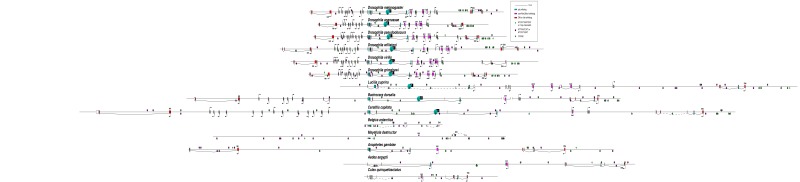
Instances of motifs similar to the EO053 conserved Hox-like motif in the pb region across Arthropods.Best to view high-quality images and zoom in and out as needed. Visualization of the pb region from the 80 species listed in Figure 6—figure supplement 1. Refer to Figure 6—figure supplement 1 for phylogenetic relationships between species. Each diagram is aligned with the pb ortholog (blue-green) underneath each species name, with labial to the left (red, if present), and Hox3 (magenta, if present) and Dfd (red, if present) to the right of each pb ortholog. Intron/exon structure shown is according to existing genome annotations; dashed lines represent approximate inferred splicing. Open brackets represent boundaries of distinct scaffolds. Locations of sequences matching (12/12 or 11/12) the sequence ATCATTAATCAT are indicated by green diamonds (see Figure 6), while similar sequences (exact matches to either ATCATTAAT or ATTAATCAT) are indicated by dark purple squares. Where green diamonds and purple squares are coincident, the Hox-like ATTAAT core remains intact. Specific Hox-like motifs that show patterns of conservation within clades are indicated by numbered ovals; these specific sequences are aligned in the accompanying Supplementary file 1. The Schizophoran EO053 motif (1; see Figure 6) is not conserved in other Diptera.